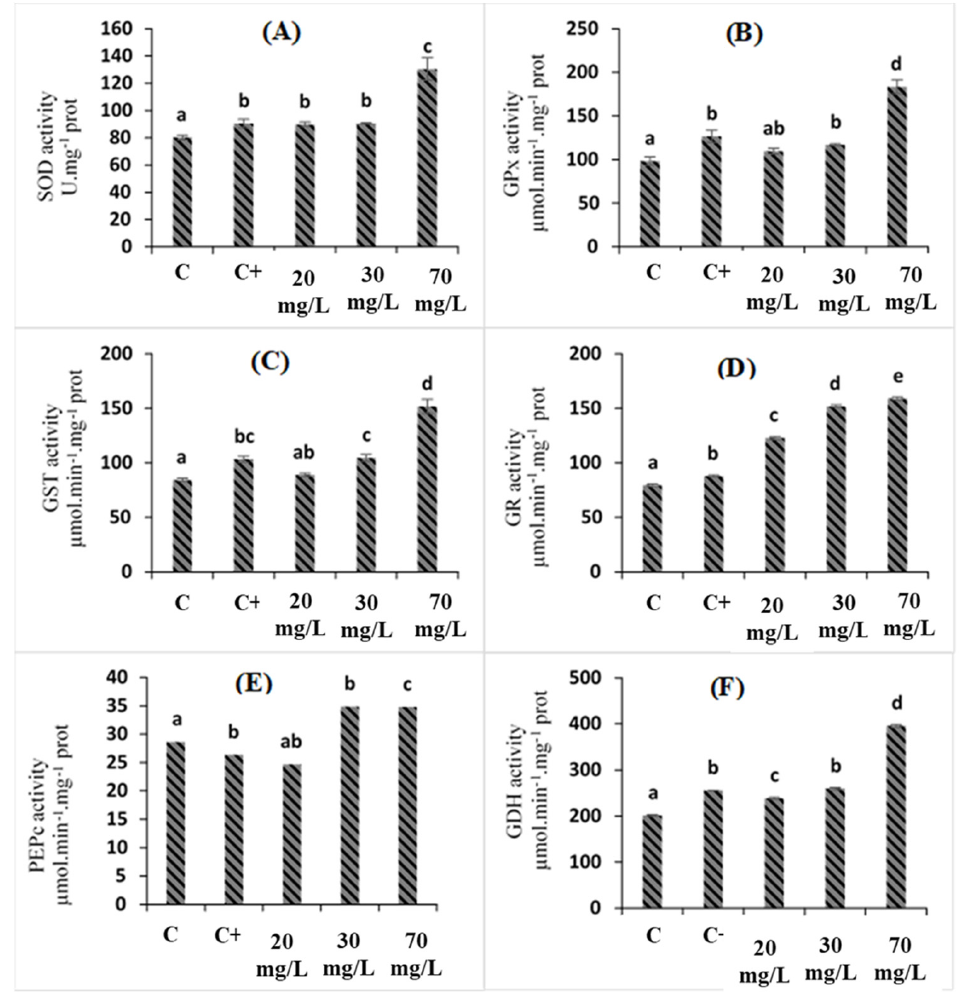
Figure 3. The effects of C. oxyacantha extract on enzyme systems in tomato plants under salt stress. Abbreviations: ( A ) SOD, superoxide dismutase; ( B ) GPx, glutathione peroxidase; ( C ) GST, glutathione S-transferase; ( D ) GR, glutathione reductase; ( E ) PEPc, phosphoenolpyruvate carboxylase; ( F ) GDH, glutamate dehydrogenase. Different letters indicate significant differences between conditions ( p < 0.05) within conditions according to Tukey’s multiple range